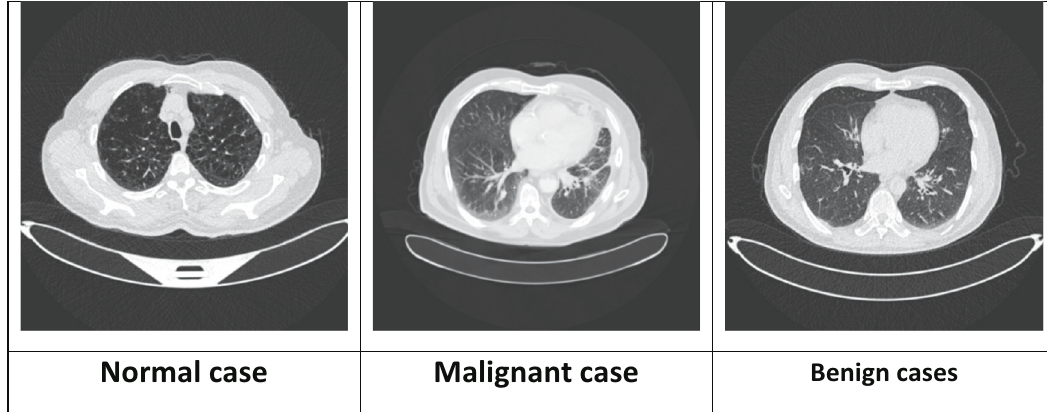
Figure 4: Sample of three types of CT SCAN of patients in classi fi cation